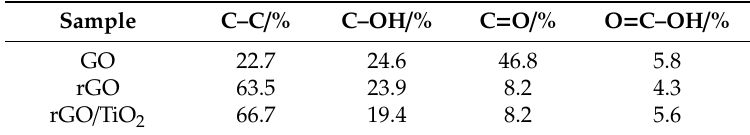
Table 1. Amount of various oxygenated groups before and after reduction of GO, calculated from the C1s XPS spectra.